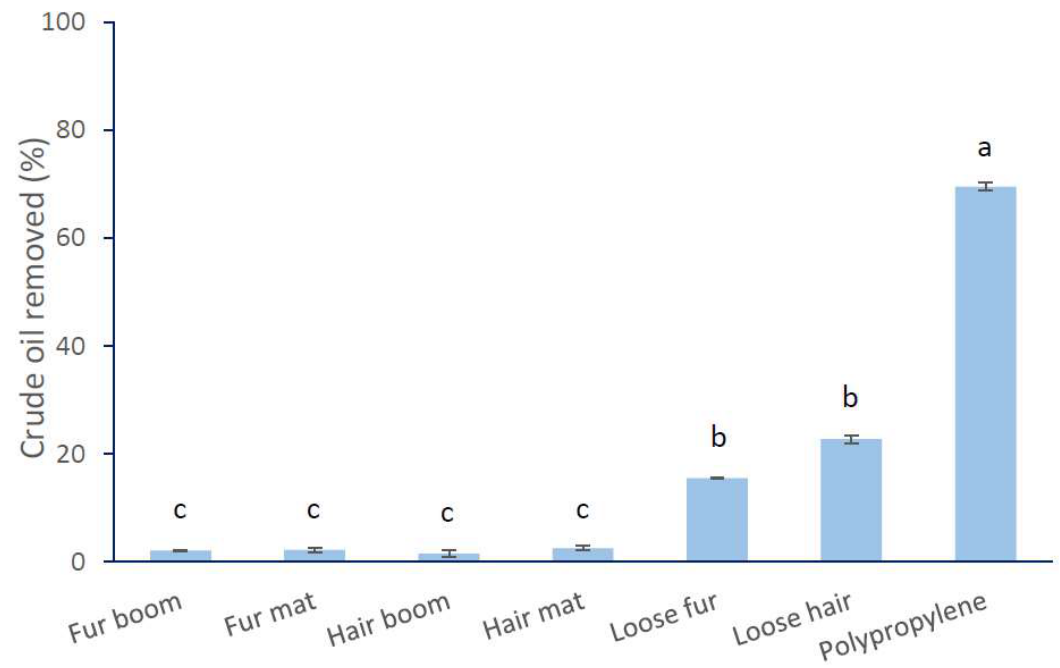
Figure 4. Crude oil adsorbed by different materials on a porous, river sand surface.